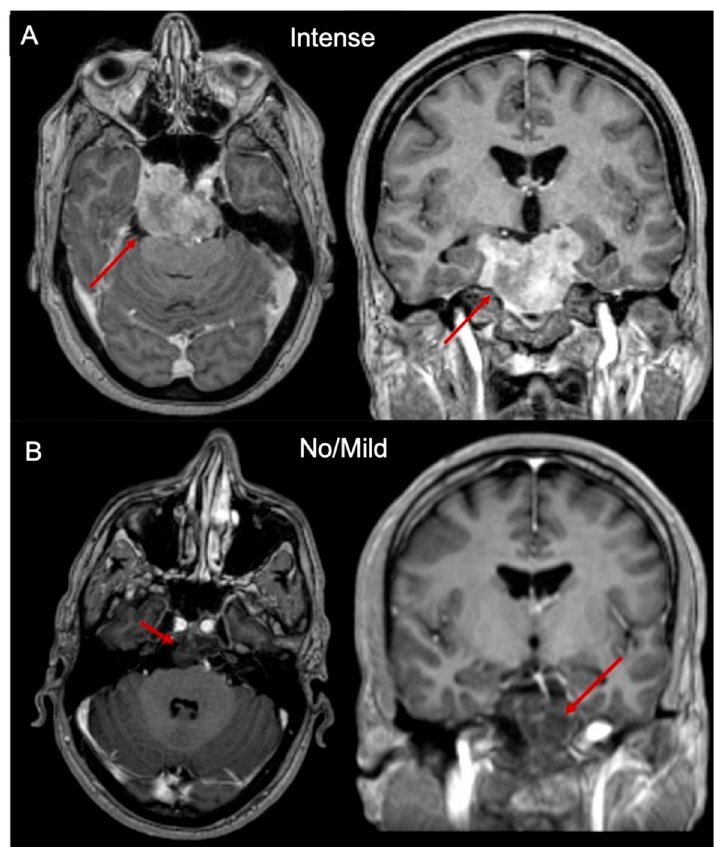
Figure 1. Axial and coronal T1-weighted post-contrast MR images showing SBC (red arrows) with intense ( A ) and no/mild ( B ) contrast enhancement.